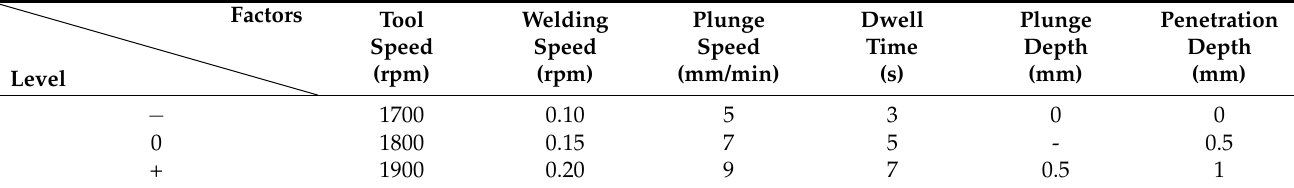
Table 2. Process parameters (factors) and their